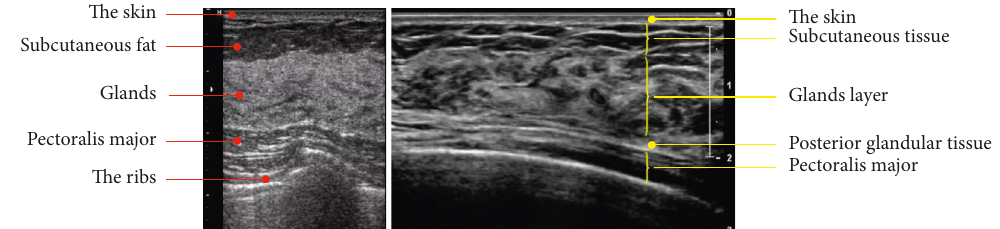
Figure 8: Comparison of ultrasound findings of healthy and diseased patients.